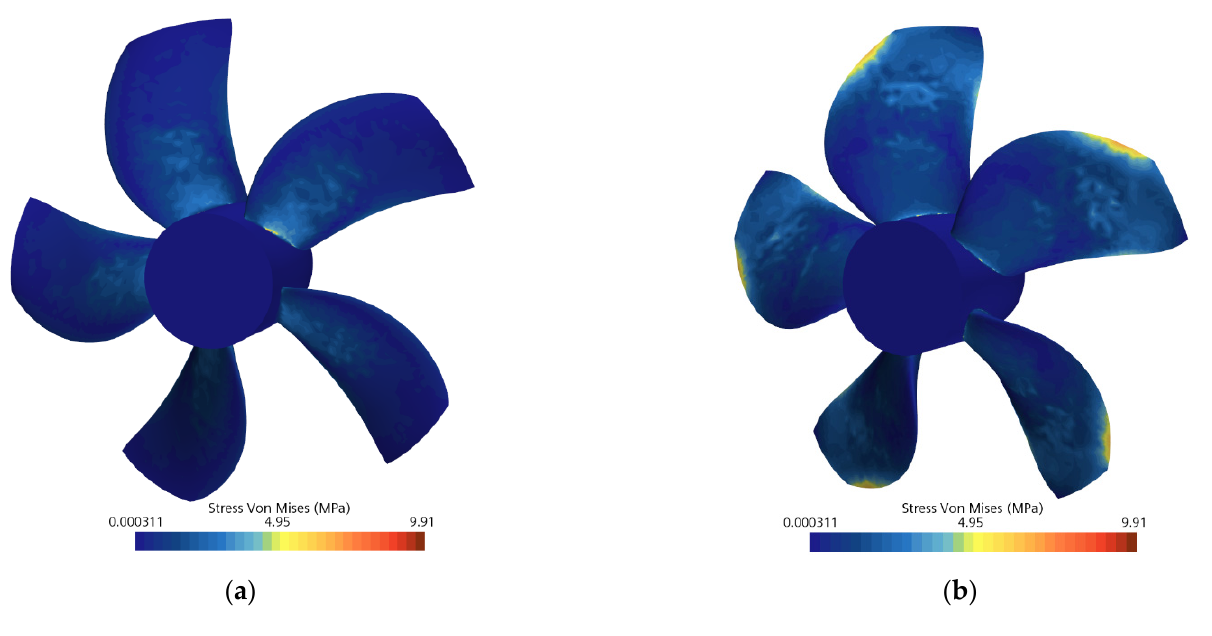
Table 4. Material model of pump-jet propulsion system.